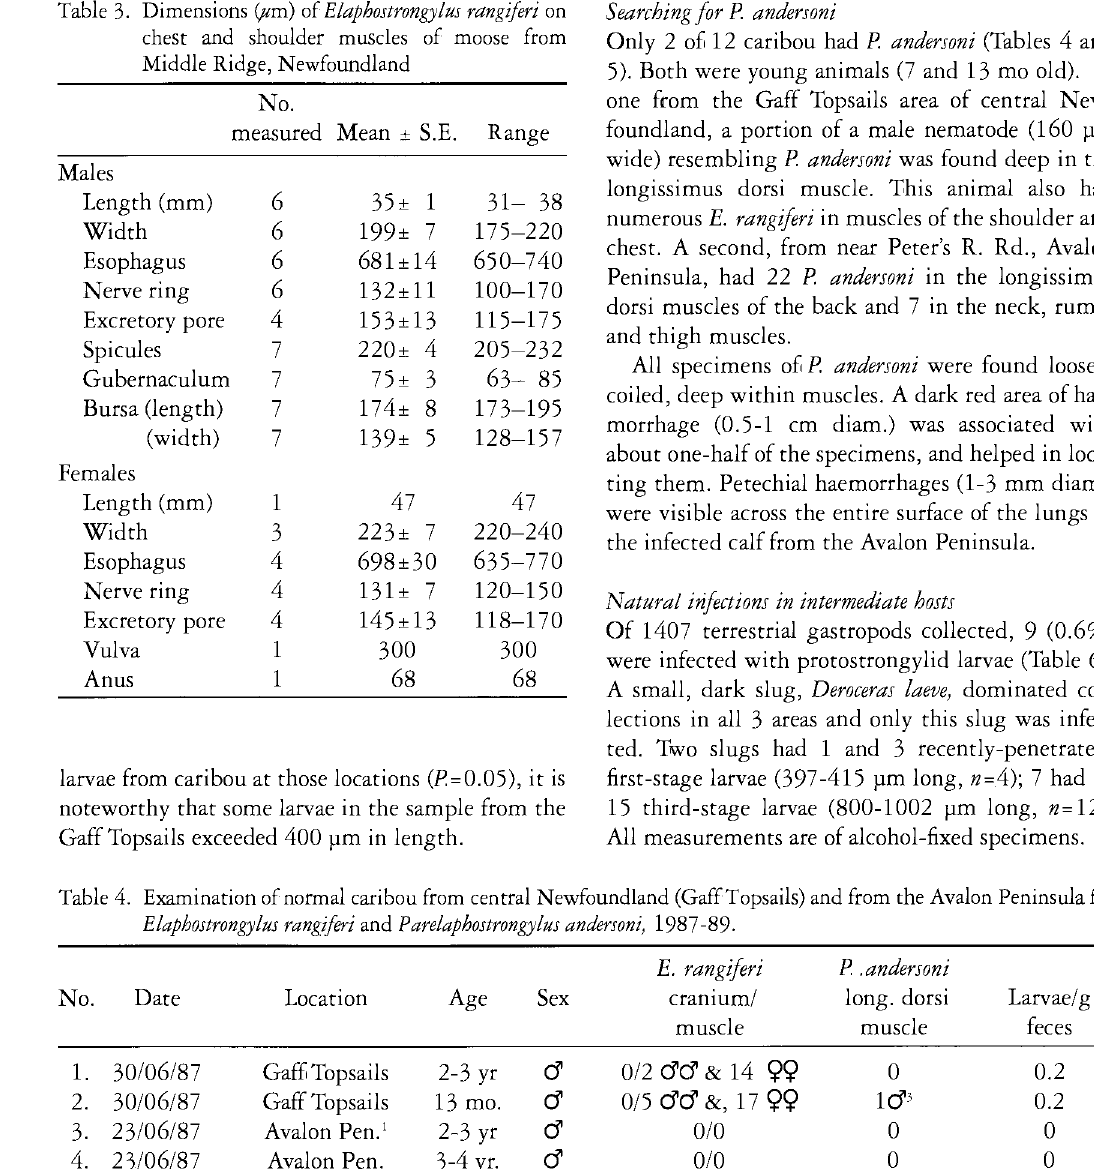
Table 3. Dimensions (/im) of Elaphostrongylus rangiferi on chest and shoulder muscles of moose from